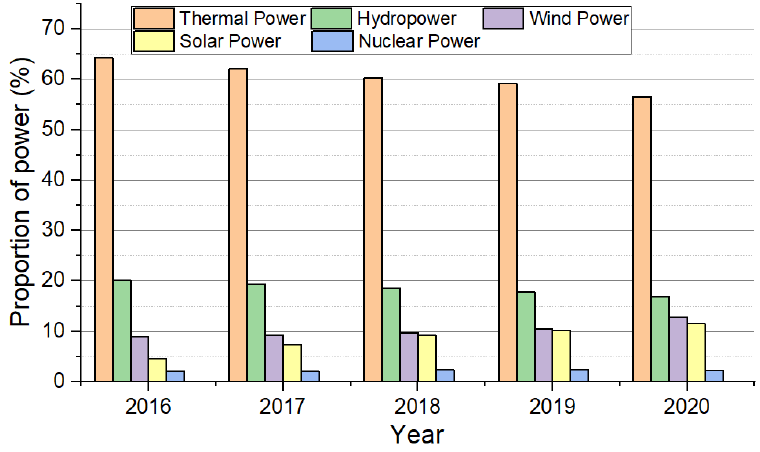
Figure 1. The proportion of China ’ s energy structure in the past five years.